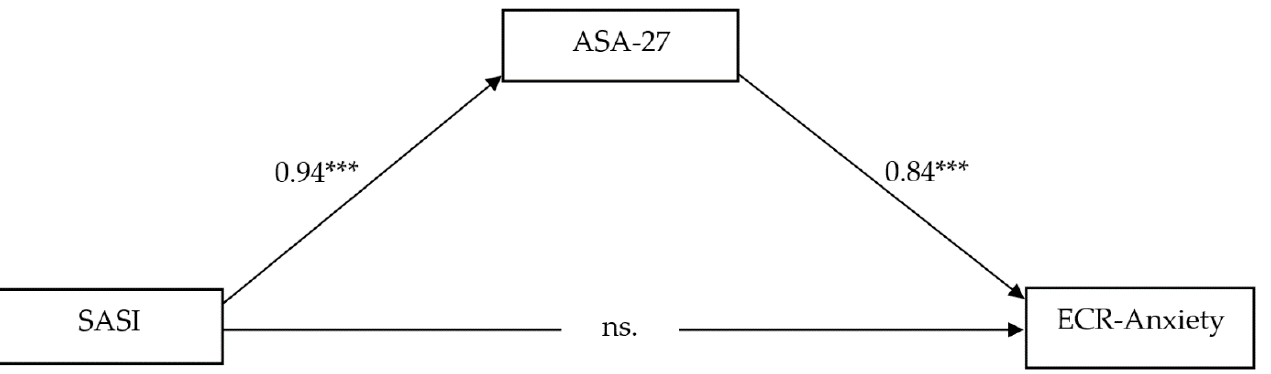
Figure 2. Mediational model. *** p < 0.00. ns = non-significant.